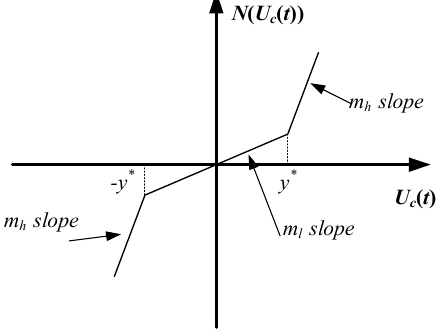
Figure 3. Schematic of three-stage nonlinear element.